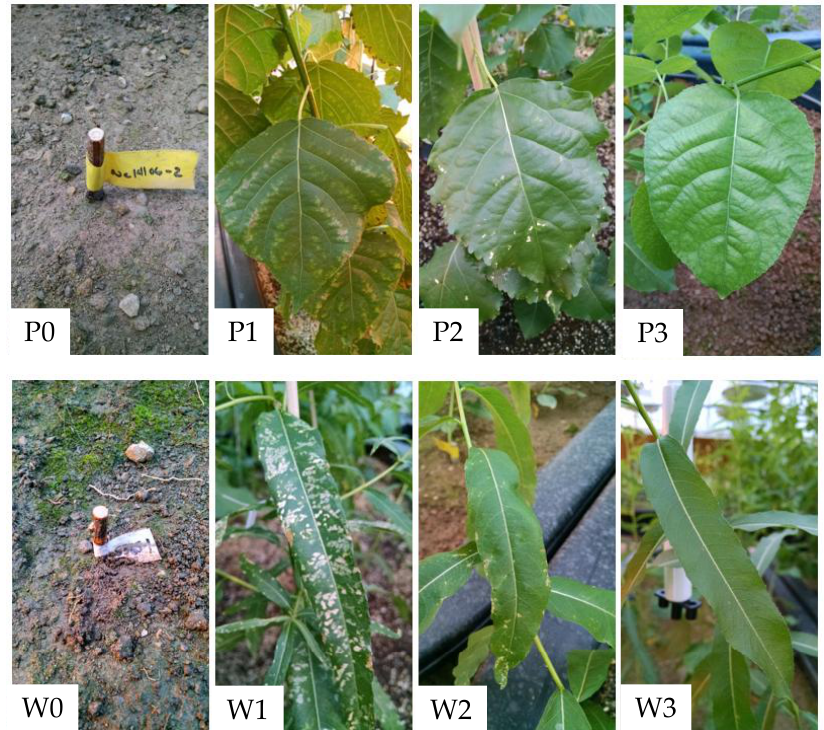
Figure 2. Photographs of tree health at 58 days after planting using a four-category qualitative scale ranging from 0 to 3, where 0 = dead, 1 = poor health, 2 = moderate health, and 3 = optimal health in a